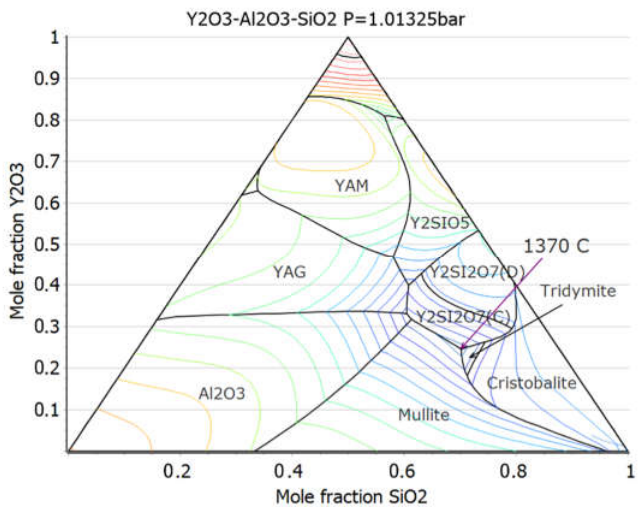
Figure 4. The phase diagram of the Y 2 O 3 -Al 2 O 3 -SiO 2 system, including isotherms at every 50 °C from 1400 °C by colored lines.